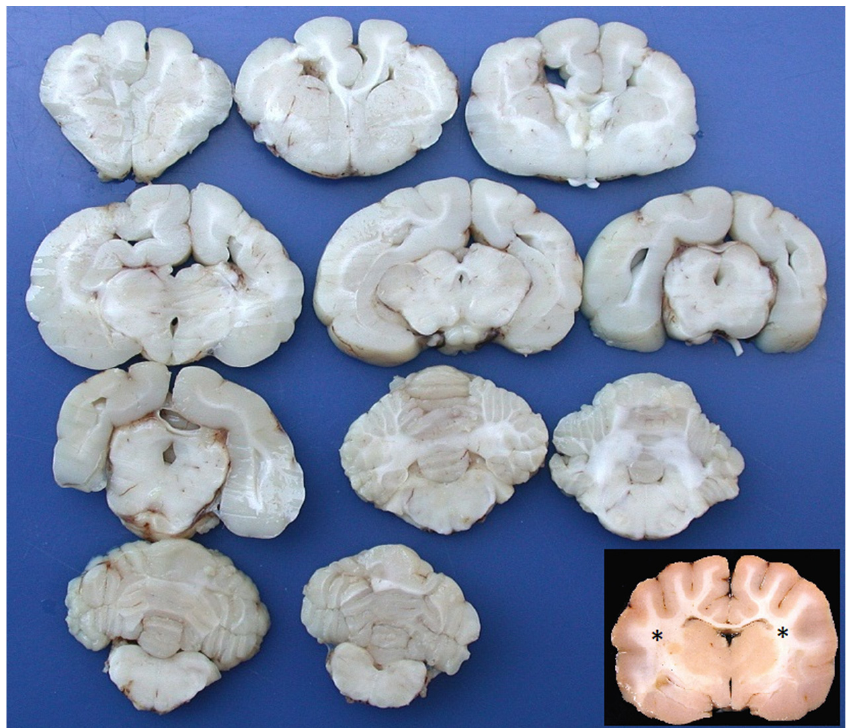
Figure 1. Cat brain. All transverse sections show the irregularly developed white matter of the telencephalon, with an absence of the corona radiata, an irregularly thickened cortex, a loss of sulci, and a broadening gyri, giving the brain a lissencephalic appearance. Basal nuclei, thalamus, brain stem, and cerebellum were macroscopically unremarkable. Inset: normal cat brain; transverse section at the level of the thalamus, approximately the same level of the first section of the second row at the top left (asterisks = corona radiata).